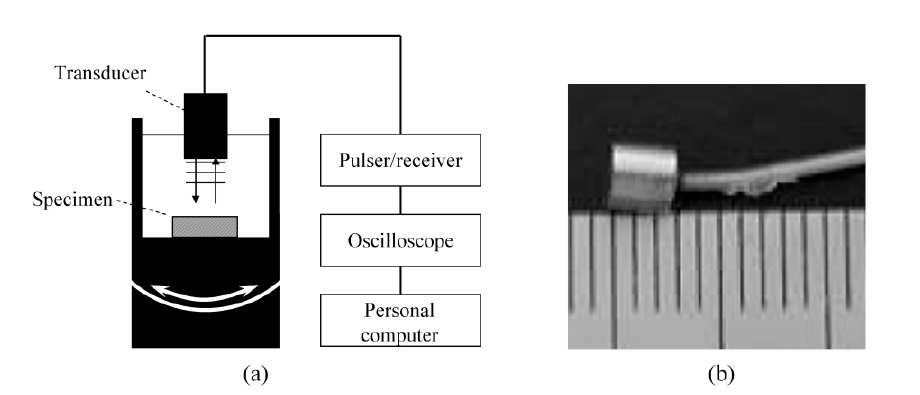
Fig. 1 (a) Schematic drawing of ultrasound measurement system. A small transducer was fixed over the measurement device. Measurement was performed in saline at room temperature and A-mode echogram was measured. (b) Ultrasound transducer (diameter: 2 mm; frequency: 10